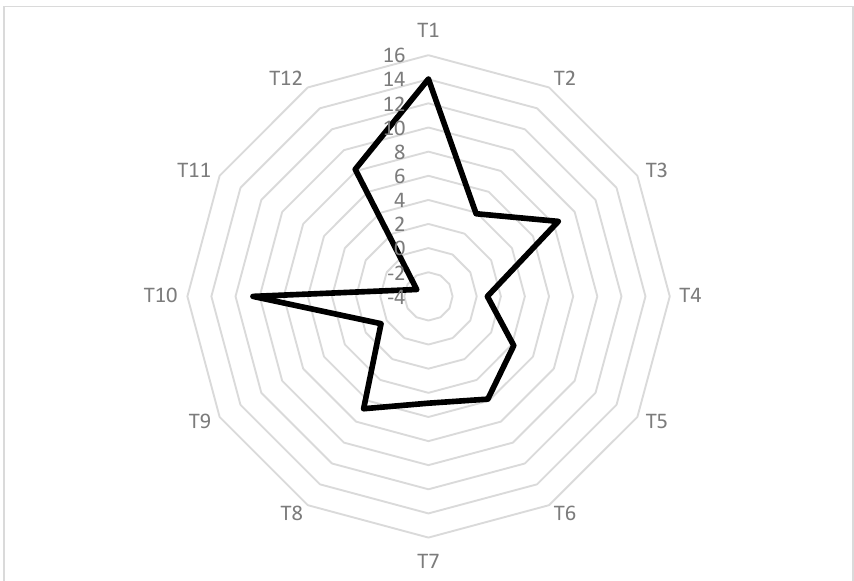
Figure 2. Radar chart for competitive analysis of different treatments.